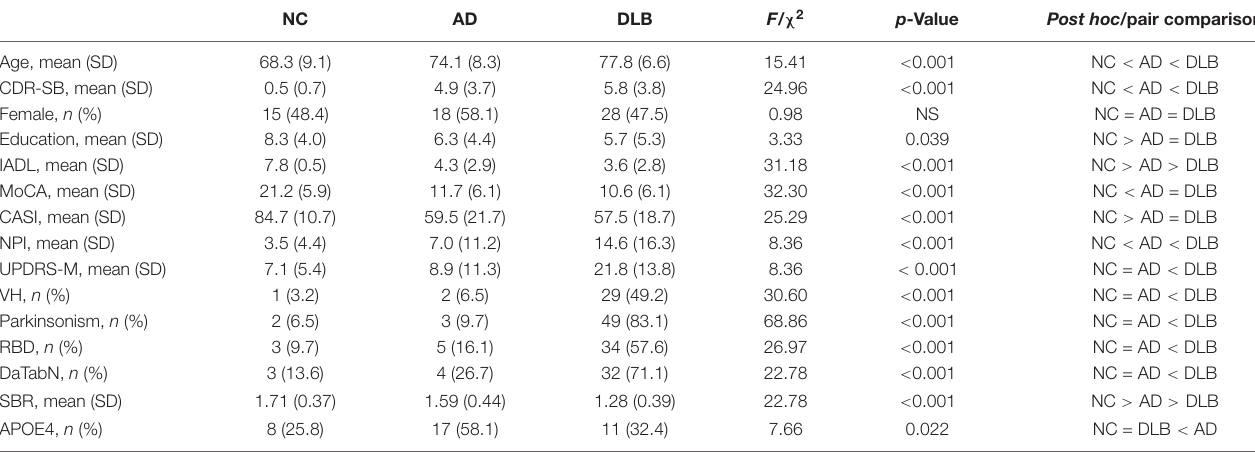
TABLE 1 | Demographic and background characteristics of NC ( n = 31), AD ( n = 31), and DLB ( n = 59) patients. NC AD DLB F / χ 2